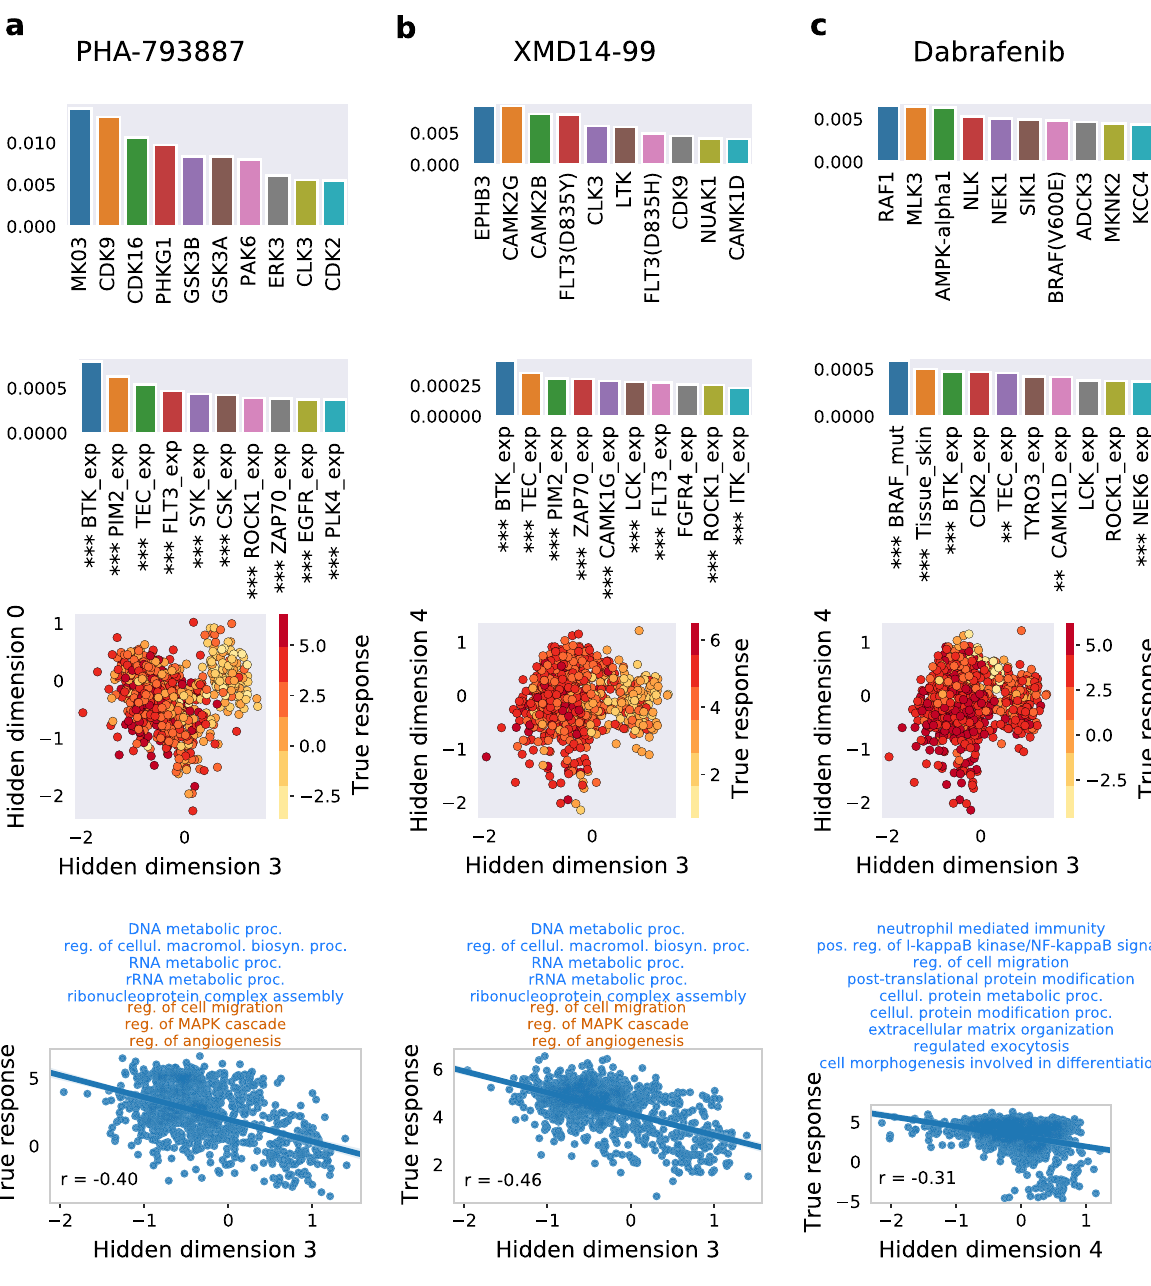
Figure 3. Case studies corresponding to compounds: ( a ) PHA-793887, ( b ) XMD14-99 and ( c ) Dabrafenib. Top row panels: top ten most important drug features for a response prediction by the model, derived using Integrated Gradients. Second row panels: top ten most important cell lines features for a model’s response prediction. Feature names abbreviations: exp. – expression, mut. – mutation. Asterisks indicate the intervals containing the p-values of the Spearman correlation coefficients r between a given feature and log IC50 values for a given drug across screened cell lines: no asterisks – [0.05, 1), * – [0.01, 0.1), ** – [0.001, 0.01), *** – (0, 0.001). Third row panels: cell lines plotted using two chosen hidden dimensions of the cell line hidden space, colored by the true log IC50 values (shown for those cell lines that were screened against the presented drug). Bottom row panels: scatter plots of true log IC50 values w.r.t. hidden dimension most correlated with the response for a given drug. The presented r values are the Spearman correlation coefficients. Text on top shows which GO terms are enriched in a considered hidden dimension, following Fig. 2, where blue and brown colors correspond to positive and negative enrichment, respectively. See Fig. 2 for term names abbreviations. For graphics, we used Matplotlib 67 , seaborn 68 , and Inkscape version 1.1 (https:// inksc ape.